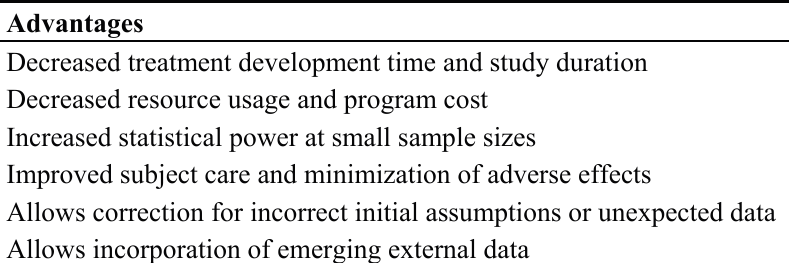
Table 2. Advantages and disadvantages of adaptive